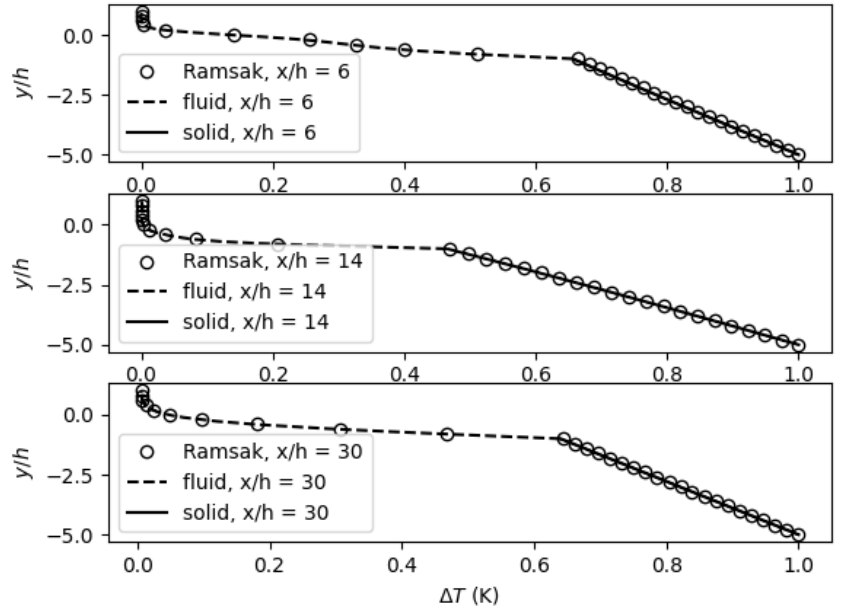
Figure 5. Comparison of temperature profiles at three locations downstream of the step, Re = 800, Pr = 0.71, ¯ k =